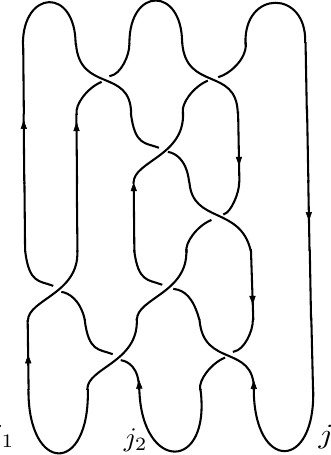
Figure 19 . A plait representation for 6 3